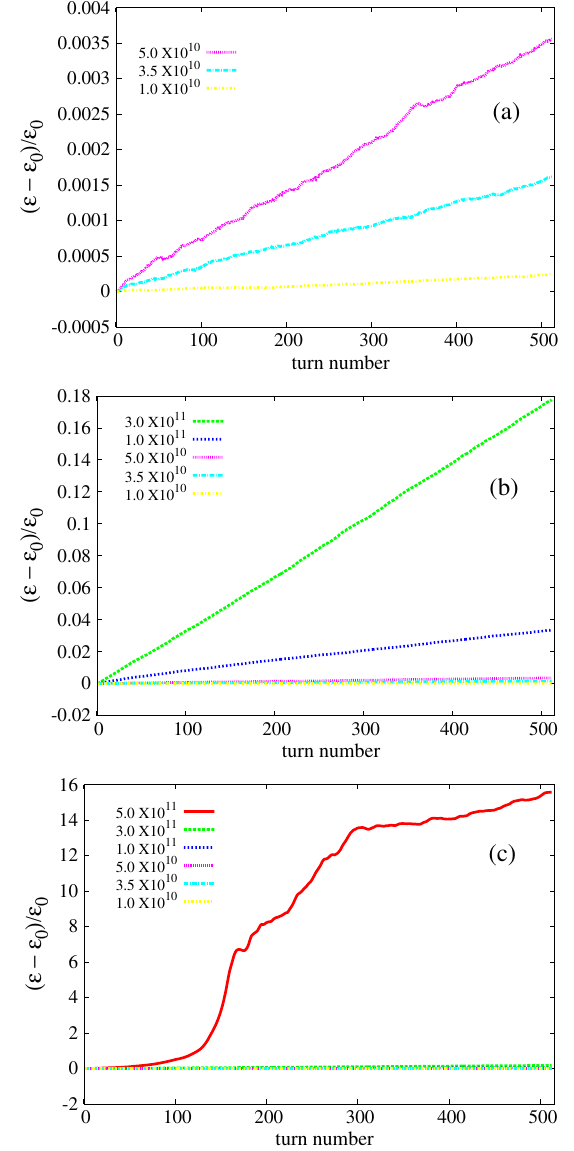
FIG. 20. Modeled relative vertical emittance growth using the continuous-focusing model for various cloud densities. (a) The relative growth rate over 500 turns is 0.16% for an average density of 3 . 5 × 10 10 m − 3 , which is the value determined by the cloud buildup modeling for the ILC DR. (b) The growth rate increases to 18% in 500 turns for a density of 3 . 0 × 10 11 m − 3 . (c) Exponential growth is found for a density of 5 . 0 × 10 11 m − 3 .